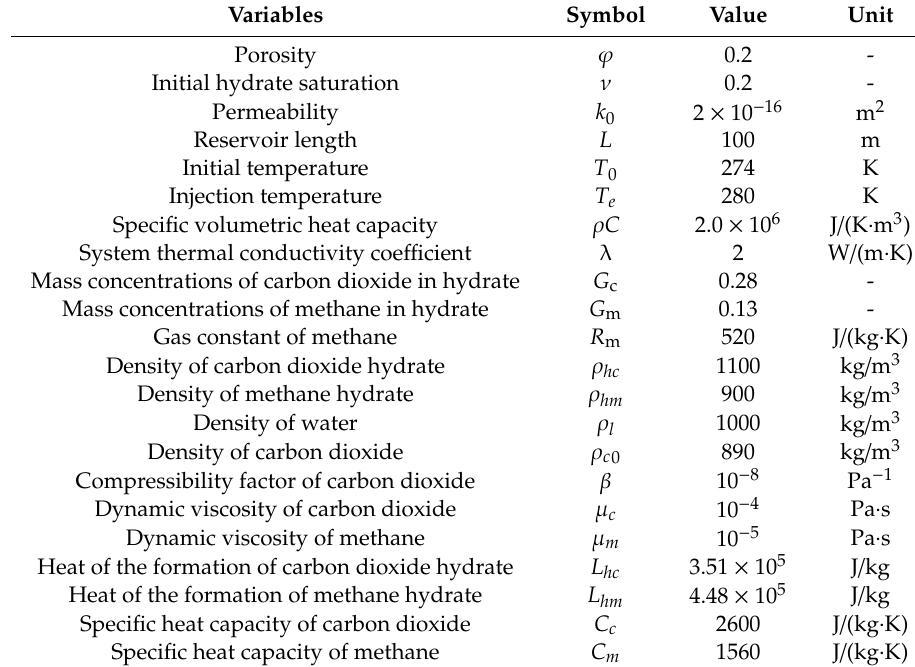
Table 1. Basic parameters for the model.